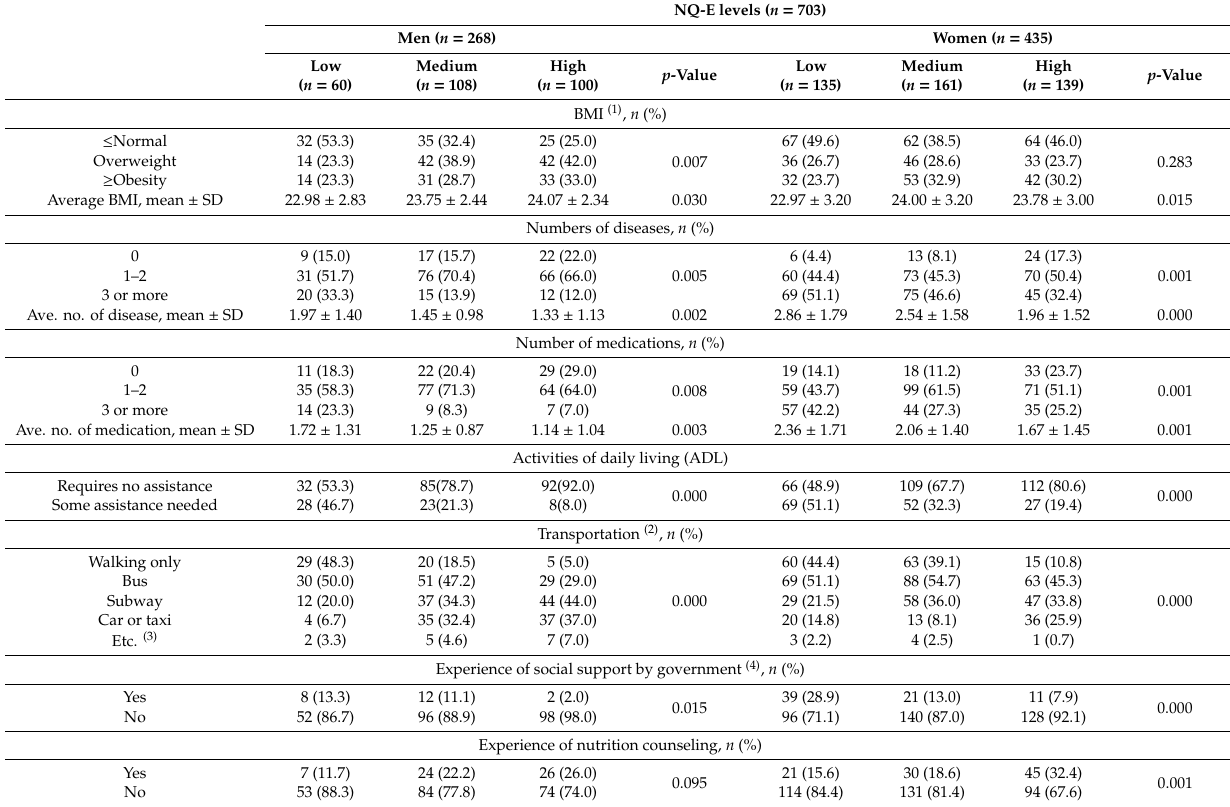
Table 3. Health-related factors of the subjects according to NQ-E